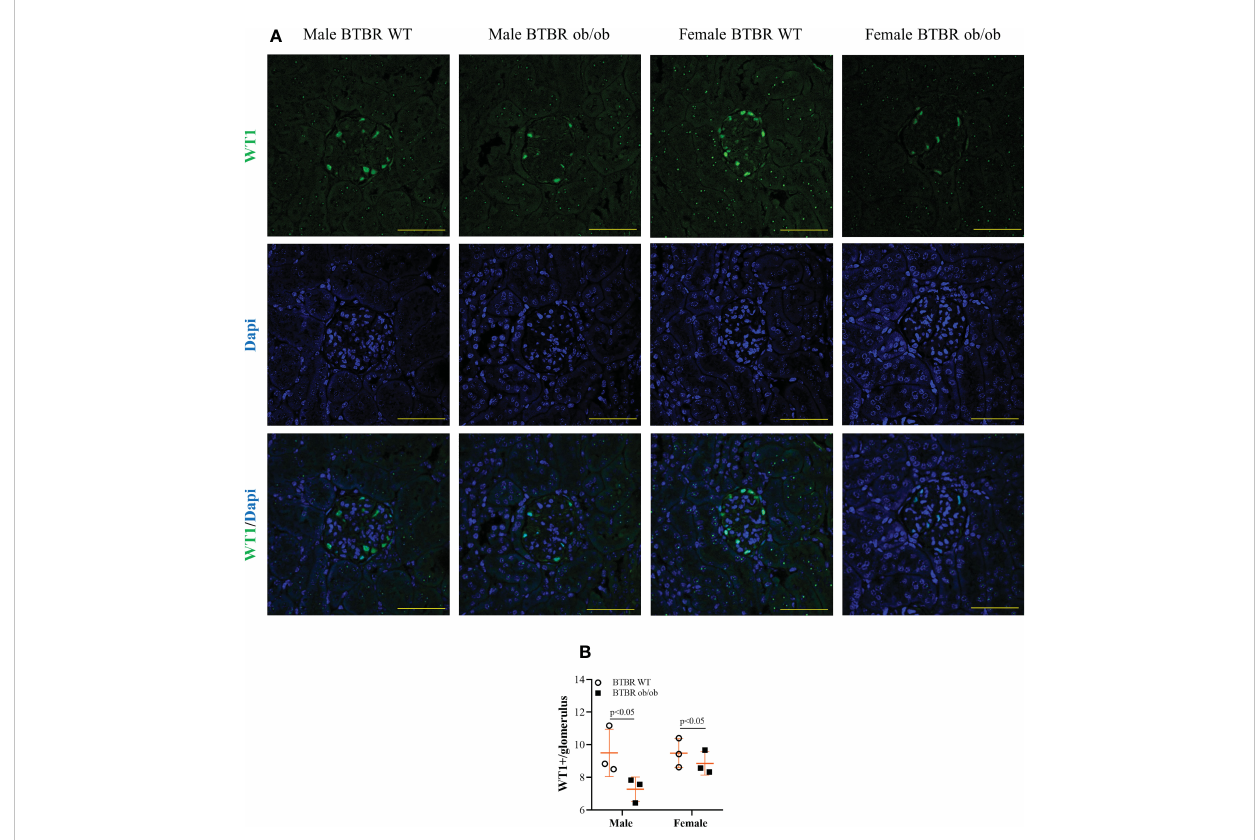
FIGURE 2 Obesity and diabetes reduce WT1 positive cells in both males and females. Effect of sex and metabolic condition on WT1 positive cells per glomerulus. Representative images of WT1 and DAPI staining (A) and glomerular WT1 positive cells quantitation (B) . The values are the mean±SD (n=3). Immuno fl uorescence images were captured using NIS-Elements software coupled to a light microscope equipped with a 40x objective at laser excitation of 488 nm (Eclipse 80i). Bars = 50 m m. WT, wild type. p values corresponding to the independent effect of metabolic condition or sex are speci fi ed in the